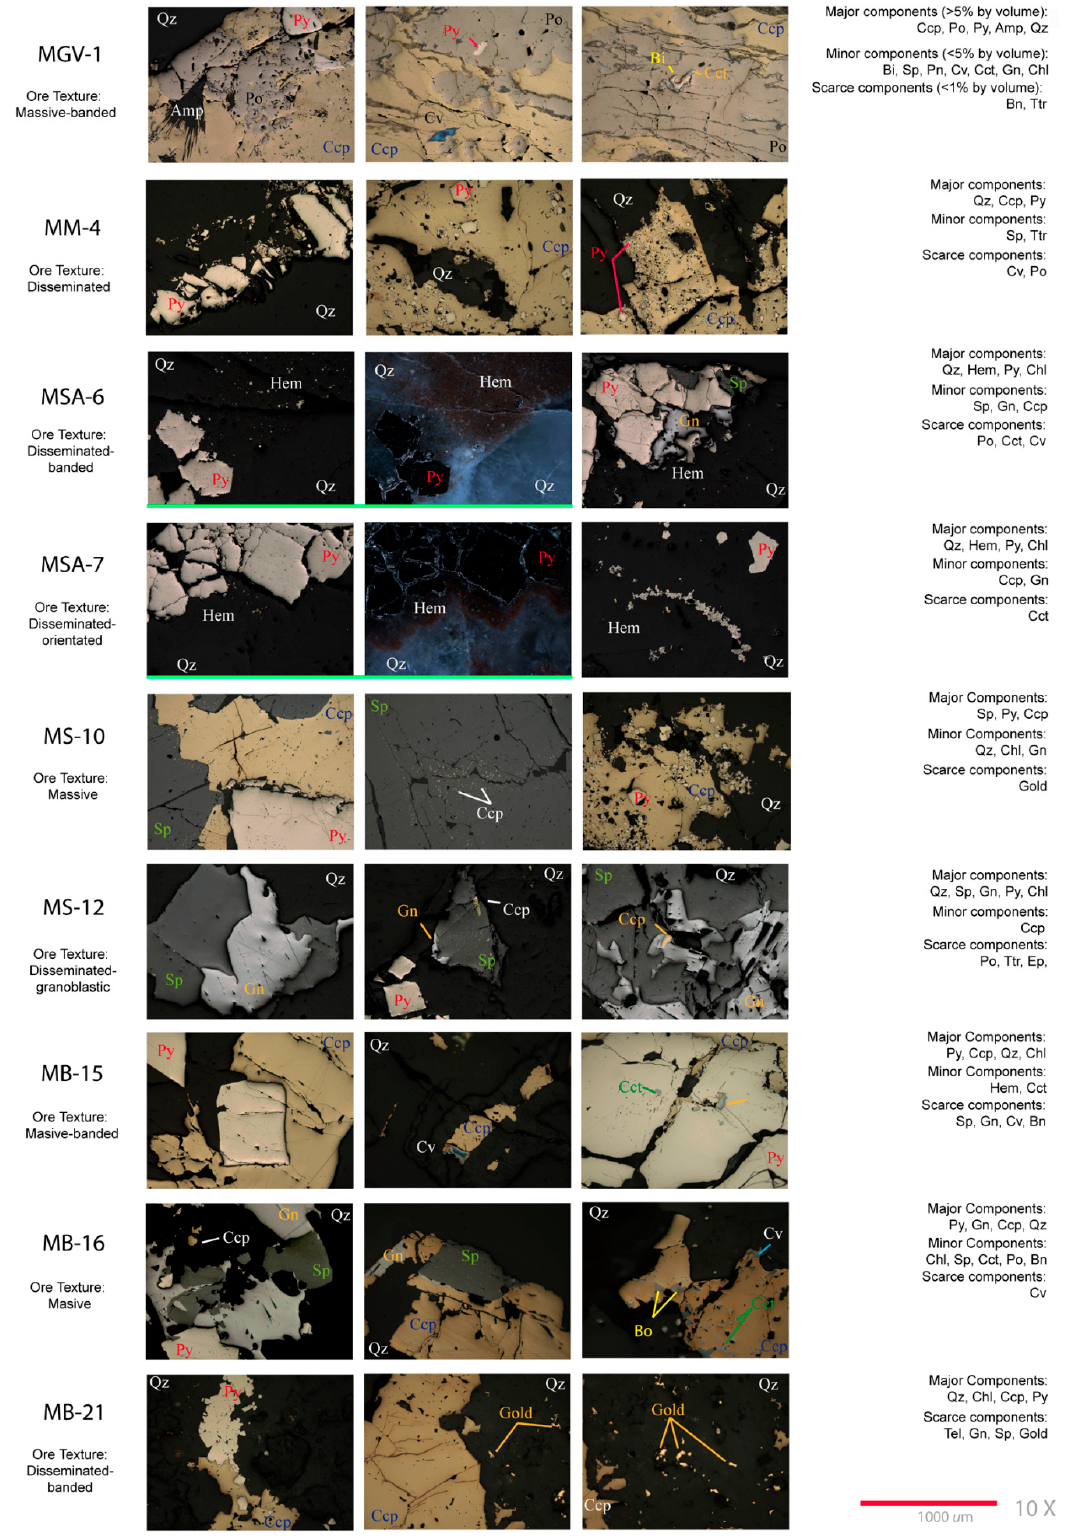
Figure 5. Reflected light photomicrographs and summary ore description of nine polished sections (objective lens magnification 10×: real grain size information provided by 100 µm scale bar at bottom right of the figure). Major, minor and scarce components are listed for each sample. Mineral abbreviations follow [50].